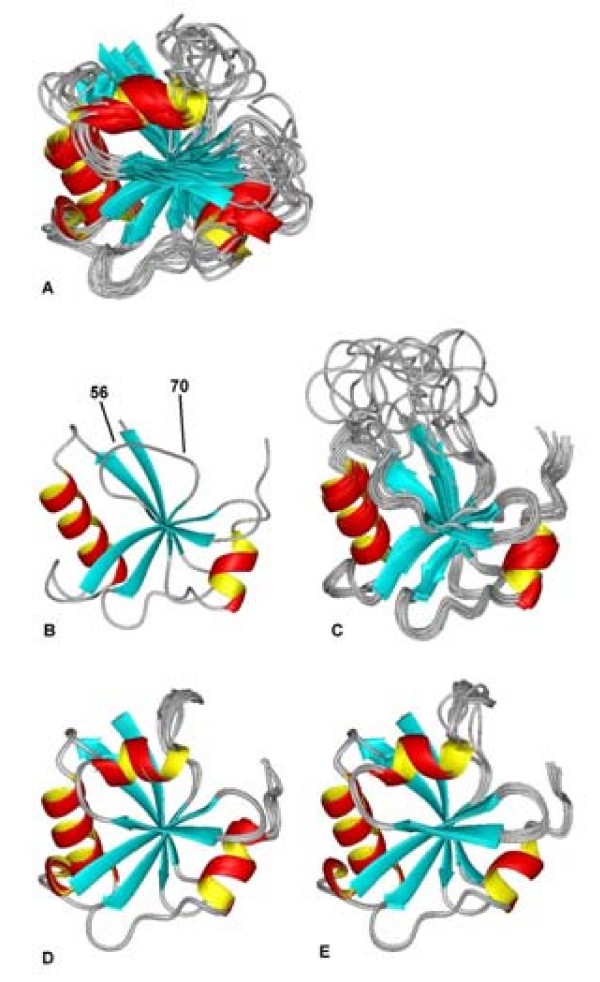
Improvement of the solution structure of Byr2-RBD by an X-ray structure of the same molecule in complex with Ras. Upper Panel: (A) NMR structural bundle of Byr2-RBD [16] [PDB ID: 1I35] (B) X-ray structure of Byr2-RBD in complex with Ras [17] [PDB ID: 1K8R]. Note that residues 57 – 69 could not be traced in the electron density map. (C) Structural bundle created from the X-ray structure by using the published resolution of 0.3 nm and the B-factors. Lower panel: (D) 10 final refined structures of Byr2-RBD without and (E) with refinement in explicit solvent.